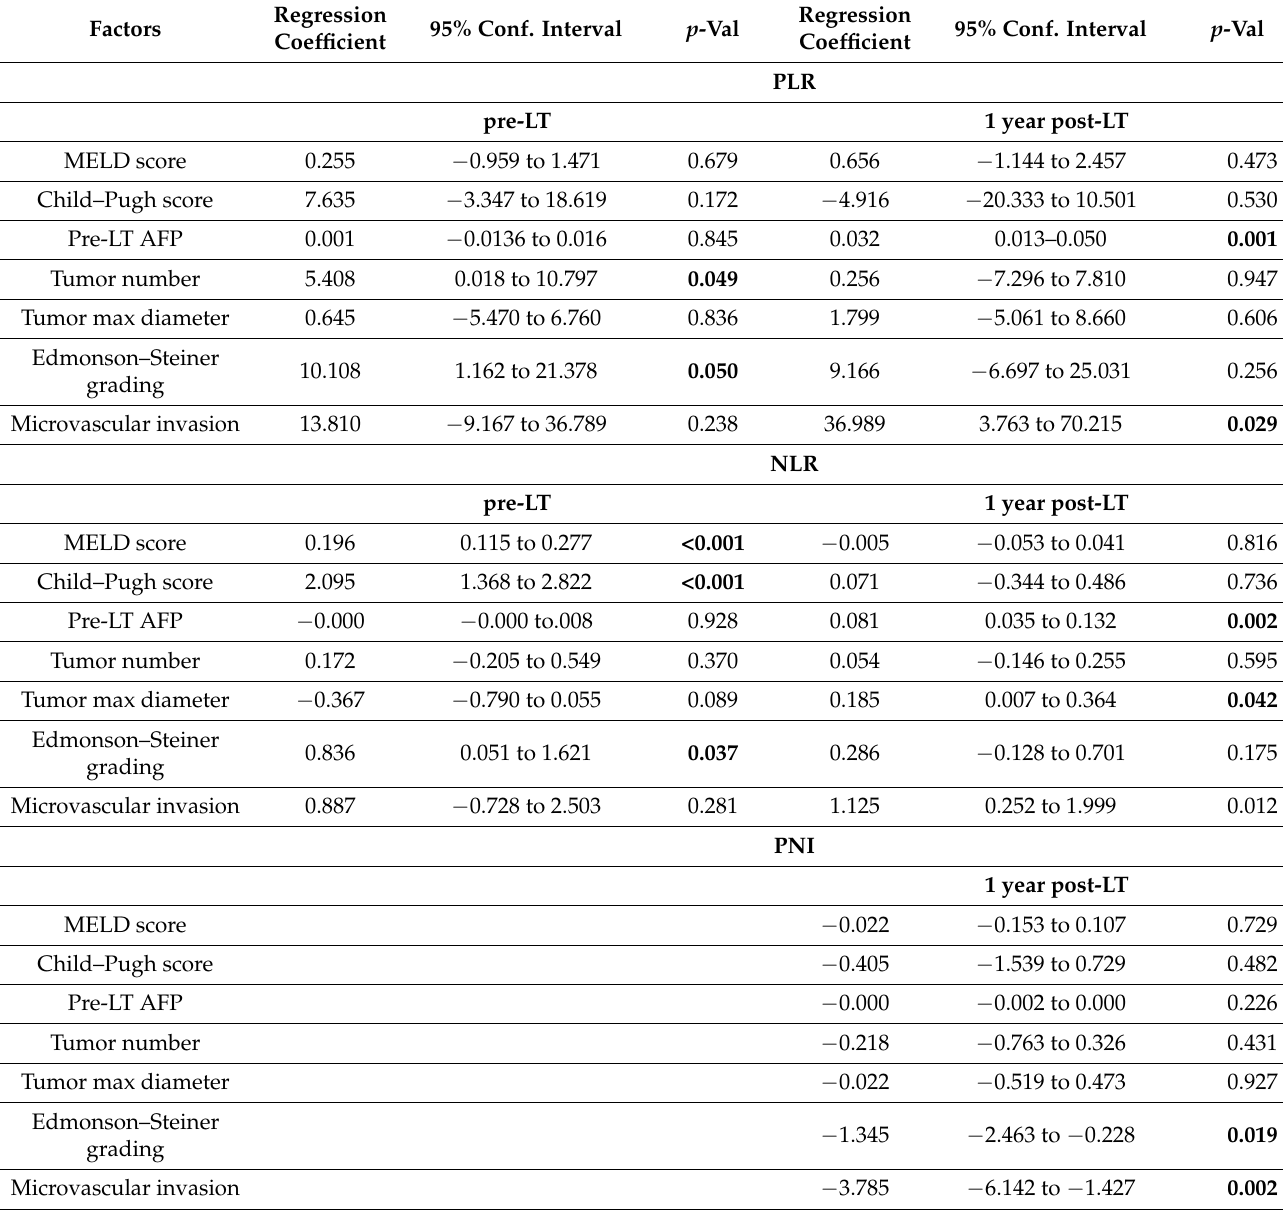
Table 5. Linear regression analysis of predictors of PLR, NLR, and